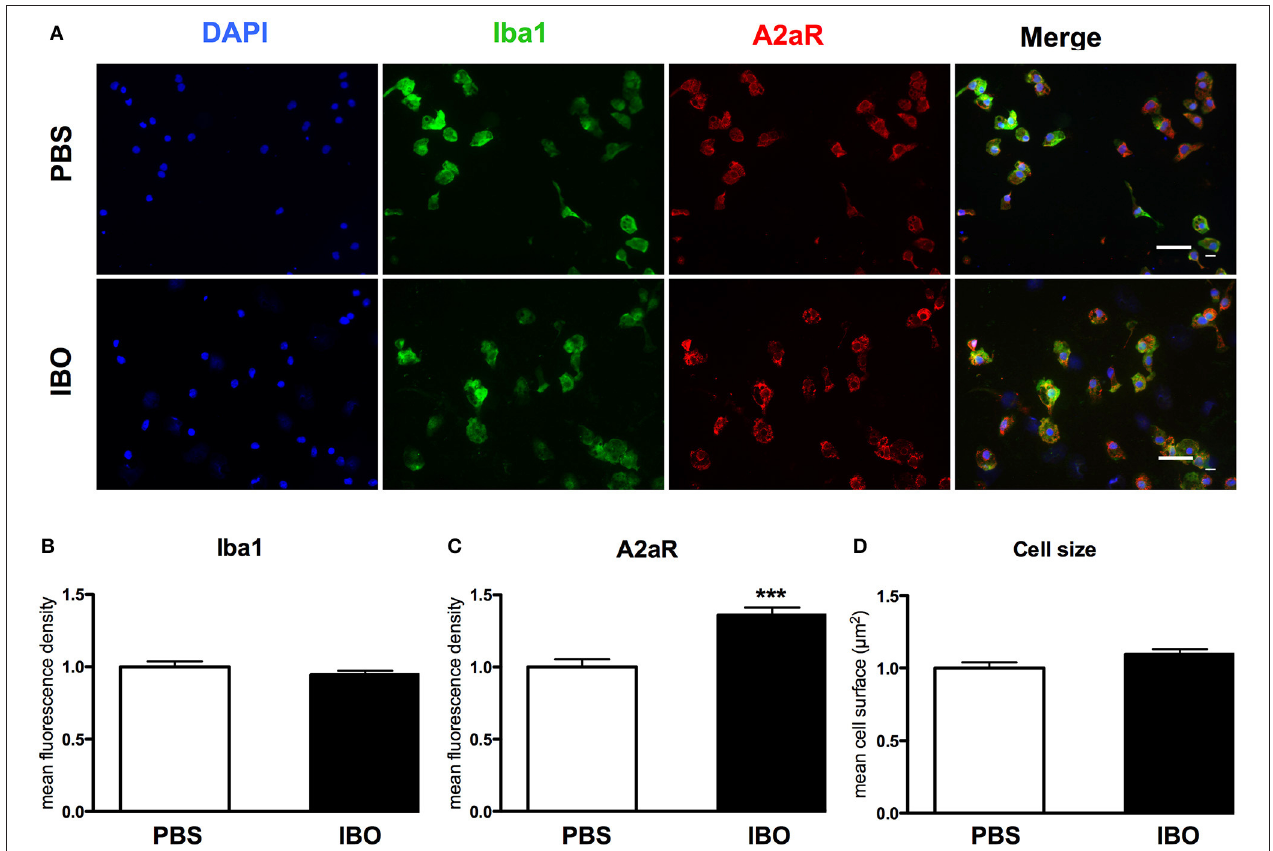
FIGURE 7 | A2aR expression in sorted microglial cells exposed to ibotenate (IBO). (A) A2aR (red) and Iba-1 (green) immunoreactivity in microglial cells sorted from P4 rat pups after 6h IBO or PBS exposure (scale bar: 50 µ m). (B,C) Quantification of mean fluorescence for Iba-1 and A2aR immunoreactivity in PBS and IBO-exposed cells. (D) Quantification of cell size on Iba-1 positive cells. Data are shown as relative expression of PBS values normalized to 1 (*** p < 0.001, using unpaired Student’s t